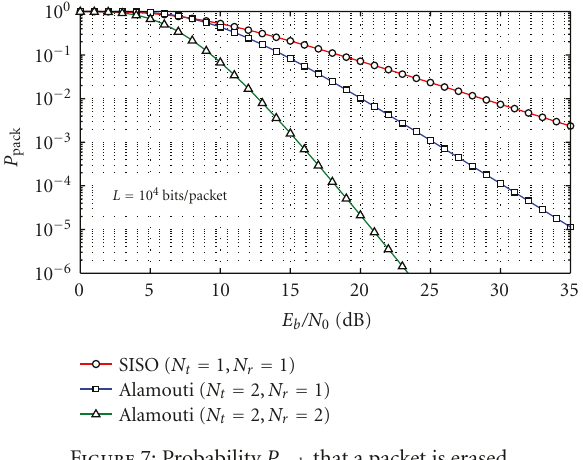
Figure 7: Probability P pack that a packet is erased.